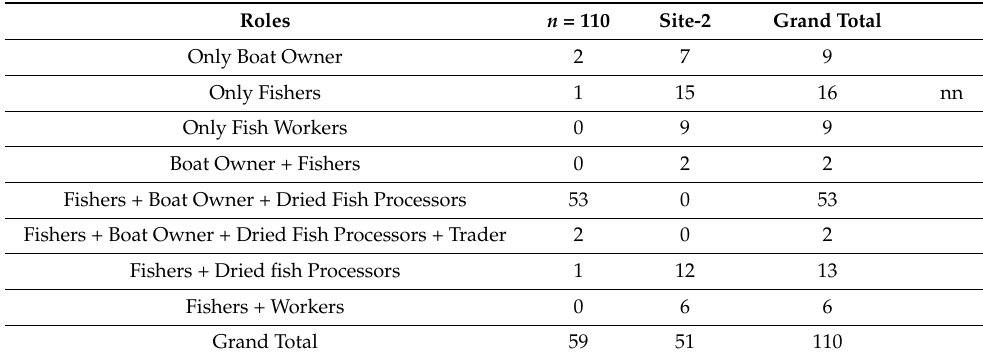
Table 5. Distribution of respondents according to their role in the upper segment of the value chain ( n =